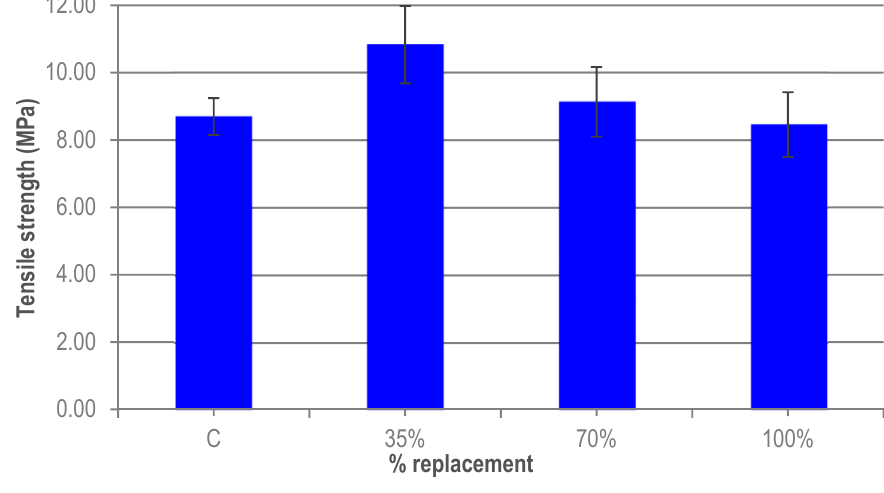
Figure 9. Tensile strength of UHPC.